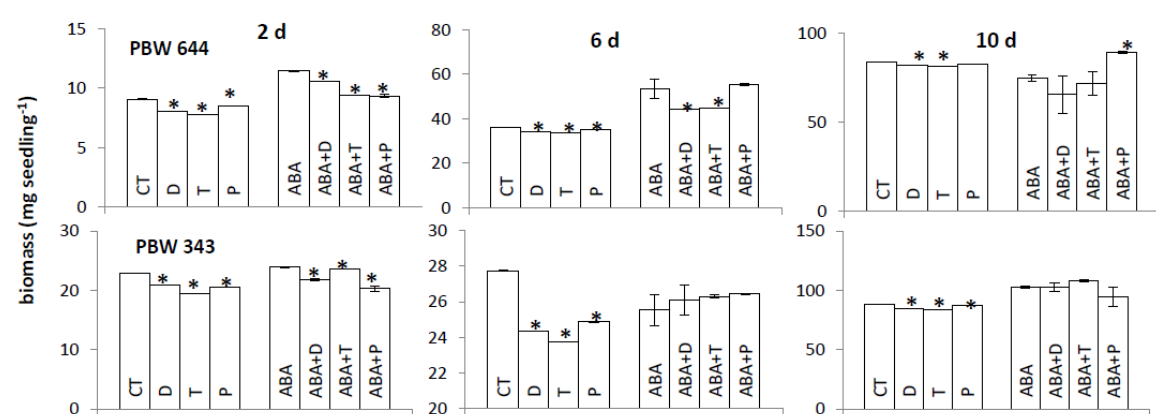
Figure 2 - ROS/NO regulation of biomass in CT and ABA treated seedlings of PBW 644 (upper panel), PBW 343 (lower panel) at 2 d (before desiccation), 6 d (desiccated) and 10 d (rehydrated) seedlings where 1 d old seedlings exposed to DMTU (D), tiron (T), PTIO (P), ABA, ABA plus D/T/P, water (CT) for next 1 d, then, desiccated for 4 d and subsequently rehydrated for 4 d. * represents significant difference from CT or ABA (Duncan Multiple test p ≤